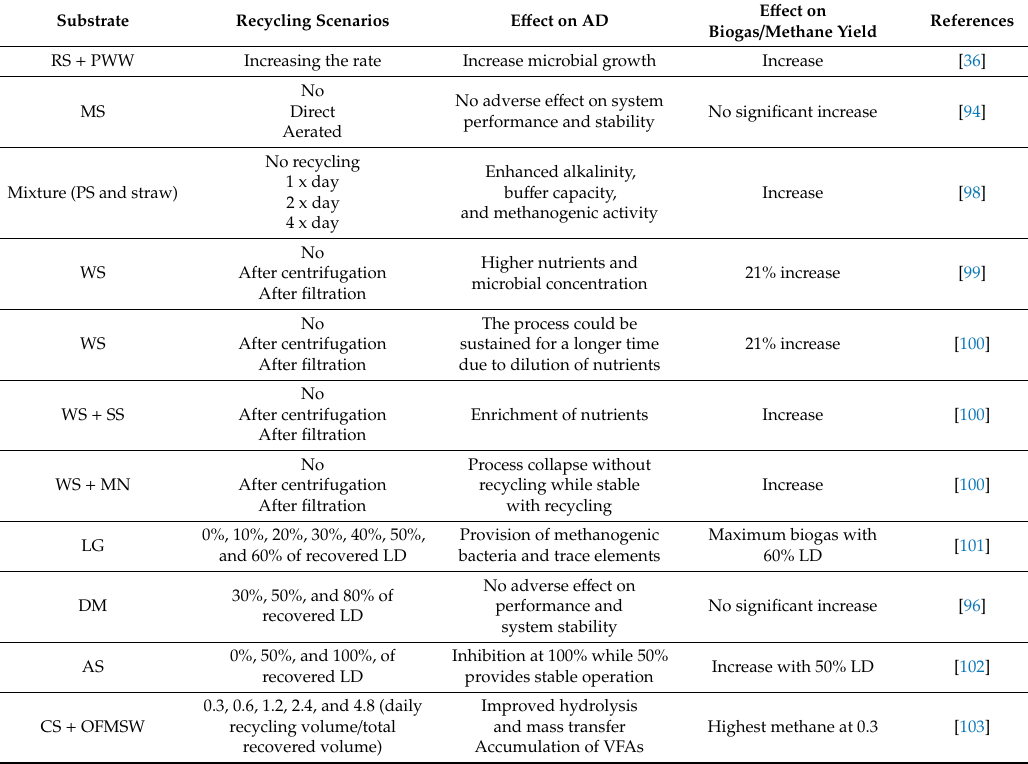
Table 8. E ff ects of recycling LD on the biogas / methane yield in AD of various substrates. Substrate Recycling Scenarios E ff ect on